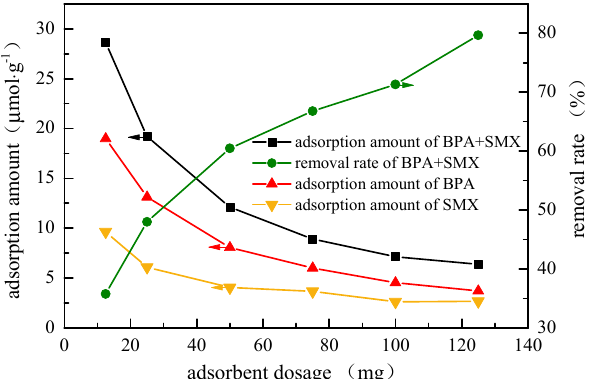
Figure 4. E ff ect of adsorbent dosage on adsorption Figure 4. Effect of adsorbent dosage on adsorption performance. Figure 4. Effect of adsorbent dosage on adsorption performance.